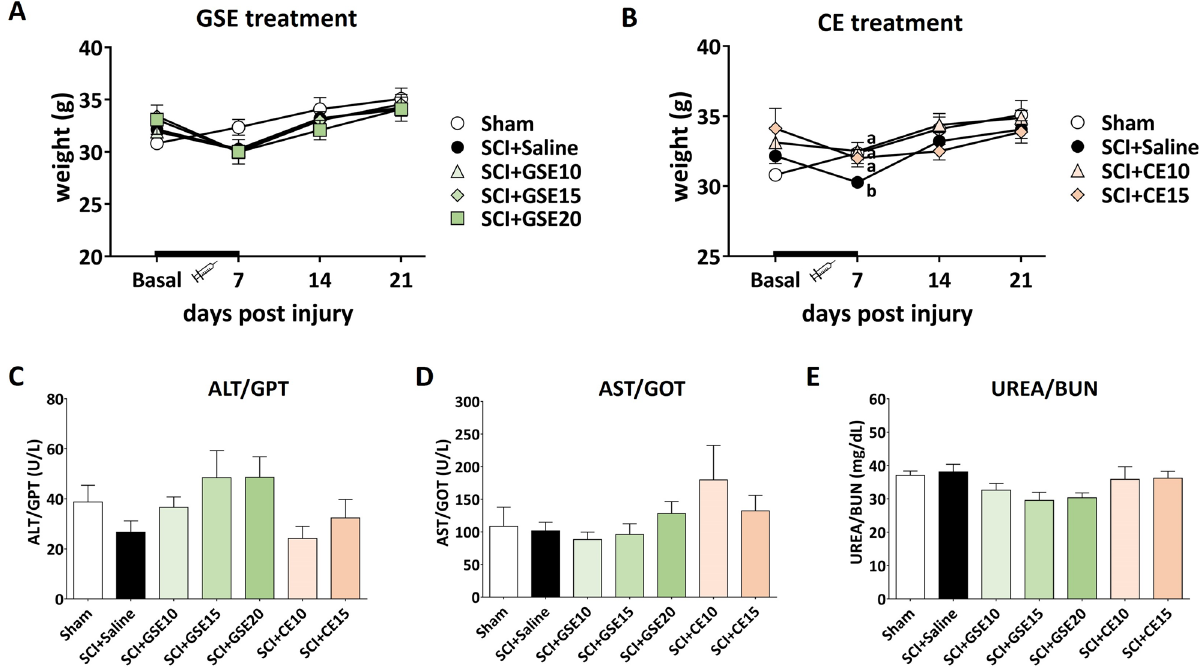
Figure 2. Mouse weight control during the injury acute phase of SCI after preventive ( A ) GSE and ( B ) CE treatment and biomarkers quantification of ( C , D ) hepatotoxicity and ( E ) nephrotoxicity in the serum of each experimental group at the end of the experimental period. The results are represented as the mean ± SEM. The treatment administration week (basal to 7 dpi) is highlighted with a thick black line ( A , B ). a–b: Groups not sharing a letter showed significant differences, p < 0.05. Experimental groups (A-B): Sham (n = 11), SCI + Saline (n = 18), SCI + GSE10 (n = 16), SCI + GSE15 (n = 14), SCI + GSE20 (n = 12), SCI + CE10 (n = 8), SCI + CE15 (n = 8). Experimental groups (C-E): Sham (ALT/GTP n = 6; AST/GOT n = 6; UREA n = 6), SCI + Saline (ALT/ GTP n = 6; AST/GOT n = 6; UREA n = 6), SCI + GSE10 (ALT/GTP n = 6; AST/GOT n = 5; UREA n = 6), SCI + GSE15 (ALT/GTP n = 5; AST/GOT n = 6; UREA n = 7), SCI + GSE20 (ALT/GTP n = 5; AST/GOT n = 5; UREA n = 5), SCI + CE10 (ALT/GTP n = 5; AST/GOT n = 5; UREA n = 6), SCI + CE15 (ALT/GTP n = 6; AST/ GOT n = 6; UREA n =